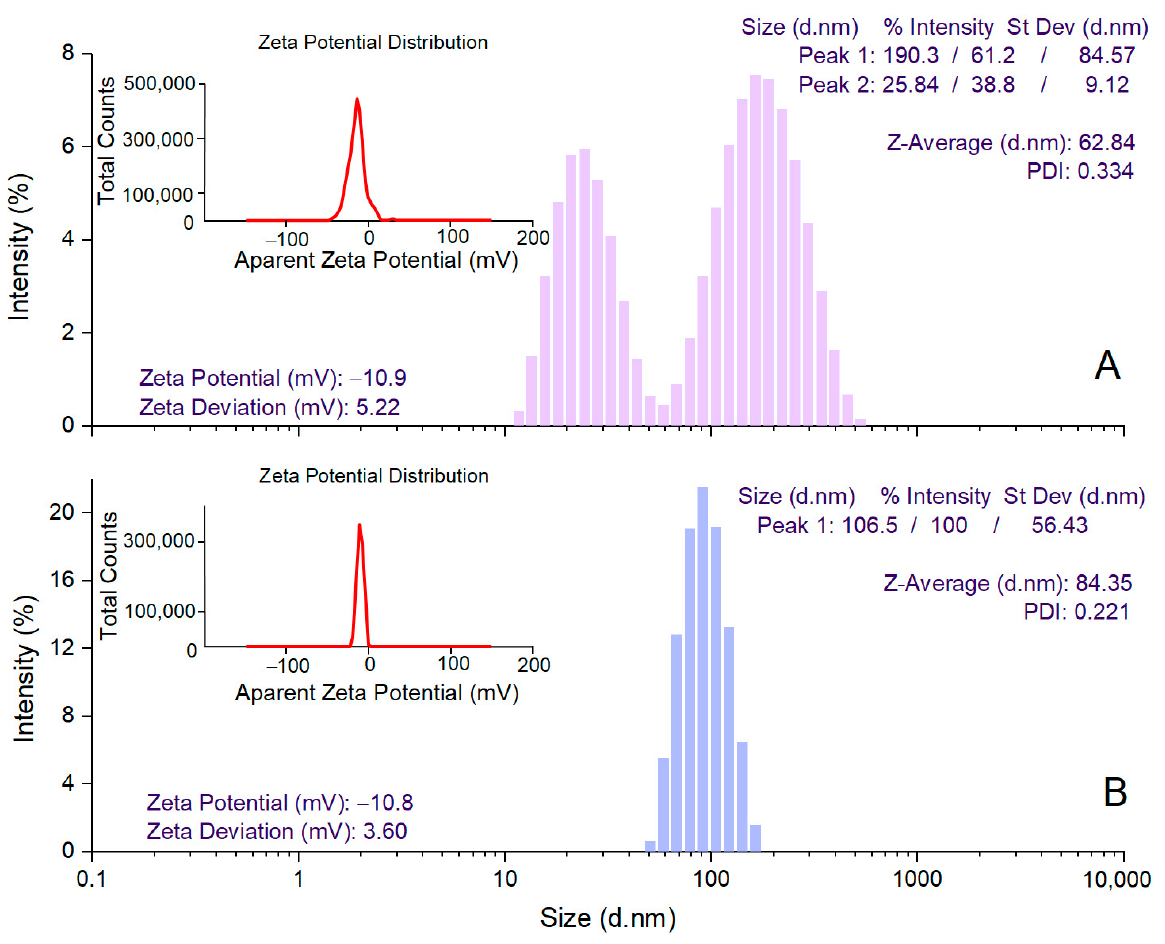
Figure 3. DLS analysis of Abies alba ( A ) and Pinus sylvestris ( B ) bark extract-derived AgNPs.